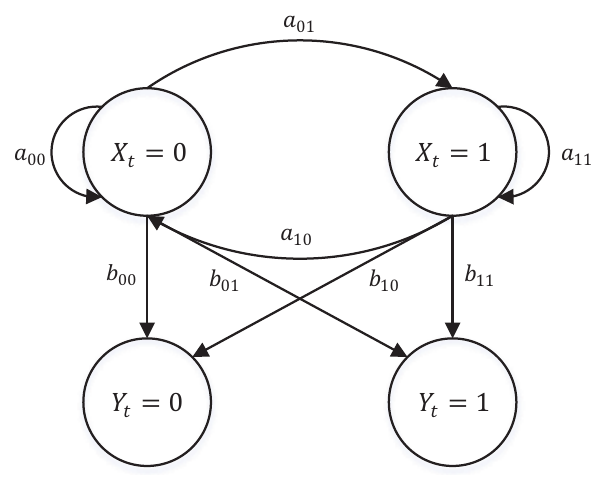
Figure 1. Hidden Markov Model (HMM)